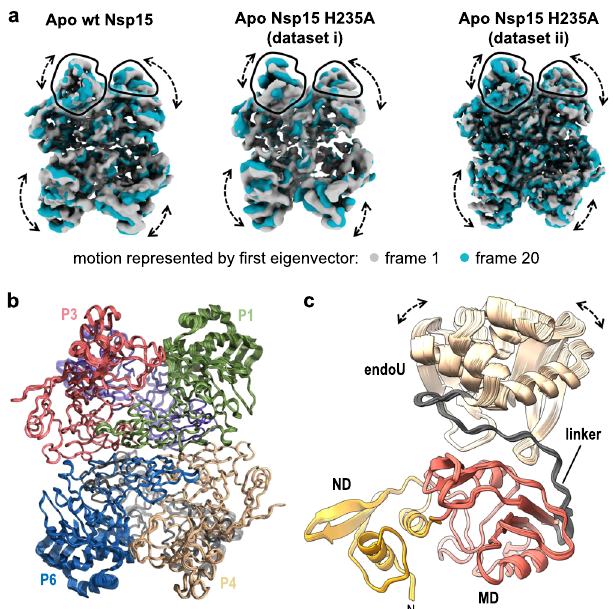
Fig. 5 3D Variability of the endoU Domain. a 3D variability analysis 28 of cryo-EM reconstructions of Nsp15 apo-states. Frame 1 (gray) and frame 20 (blue) of a 20-frame set describing the motion by the fi rst eigenvector of the cryo-EM reconstructions. Black outlines demarcate the unique views of the endoU domains and dotted arrows demarcate regions of conformational heterogeneity. b Superposition of rigid-body docked models of the Nsp15 hexamer into the Apo Nsp15 H235A (dataset ii) reconstructions derived from 3D variability analysis. c View of the individual P1 protomer from ( b ) illustrating the conformational dynamics of the endoU domain. The linker between the endoU and MD is colored in